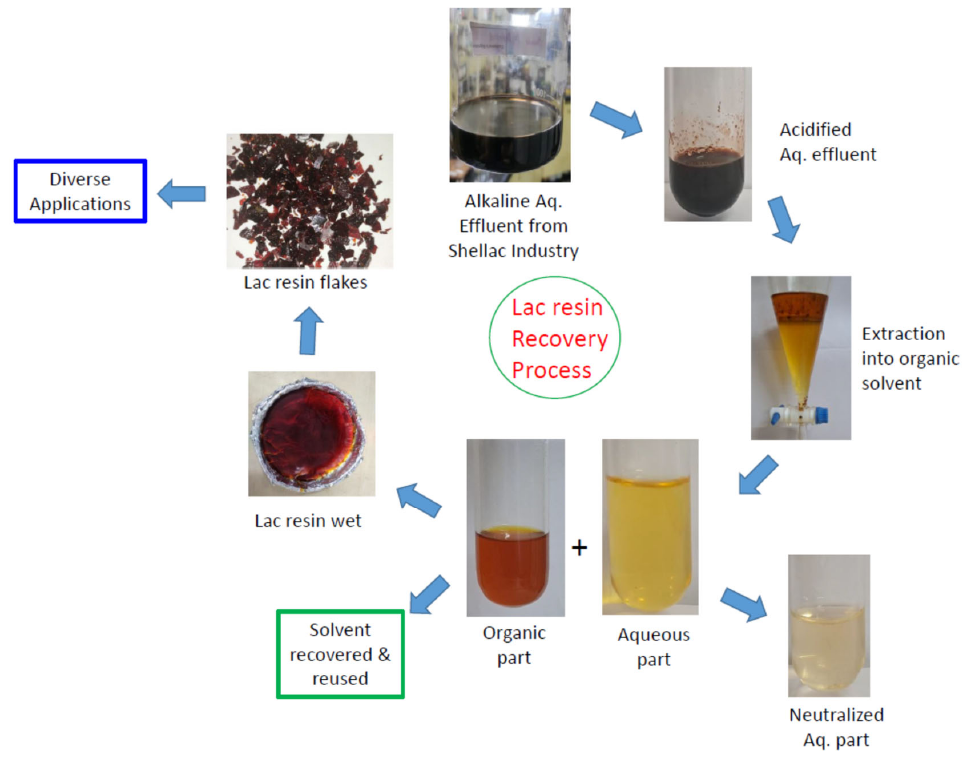
Figure 3. Schematic representation of lac resin recovery process from alkaline aqueous effluent. The 13 C ‐ NMR spectra were recorded on 600 MHz (Jeol Resonance ECZ 600R spec ‐ trometer), FT ‐ IR was recorded on Perkin Elmer Spectrum GX FT ‐ IR system and melting points were determined with Thermo Scientific MEL TEMP instrument.